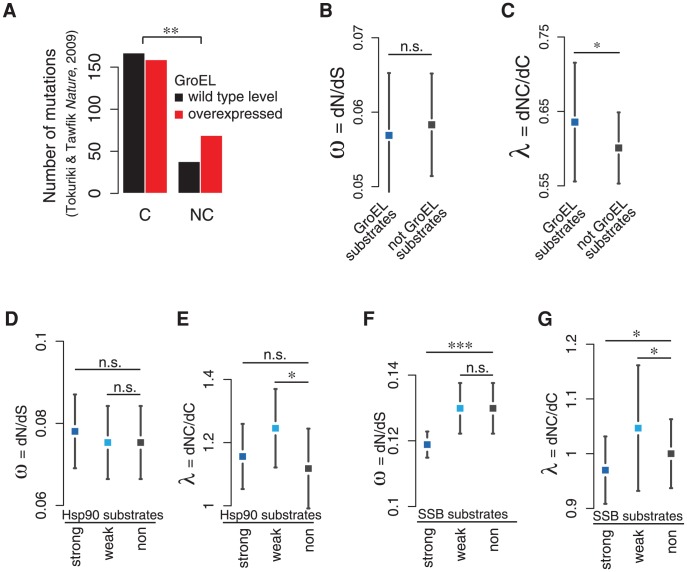
Weak chaperone dependence promotes NC substitutions.
A The over-expression of GroEL in the directed evolution of enzymes reported in [6] promotes NC substitutions, thus validation the definition of NC mutations and λ. B Native substrates of the E. coli chaperonin GroEL (n = 58) do not evolve at higher ω than non-substrates (n = 216). Shown is the partial regression plot of the contribution of chaperone dependence on ω, together with 5% confidence intervals. The confidence intervals reflect the limited power of predicting a continuous variable, e.g. ω, from chaperone dependence alone. The significance of chaperone dependence is assessed by non-parametric regression analyses that explicitly include expression and disorder as confounding factors. C Native substrates of the E. coli chaperonin GroEL evolve at significantly higher λ. D Human kinases that are substrates of Hsp90 do not evolve at significantly higher ω than kinases that are not Hsp90 substrates when expression levels as confounding factor are included in the analysis. E Both strongly (n = 71) and weakly (n = 70) Hsp90 dependent kinases exhibit a significantly higher λ than non-substrates (n = 61). F Strong substrates of the yeast Hsp70 SSB (n = 648) evolve at lower ω, weak substrates (n = 310) at similar ω compared to non-substrates (n = 721). G Strong SSB substrates also evolve at lower λ, but weak substrates evolve at higher λ. Significance levels are indicated as n.s. (not significant), * (p<0.05), ** (p<0.01), and *** (p<0.001).